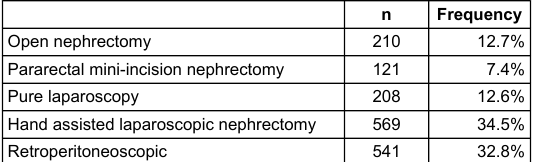
Table 2: Surgical method.